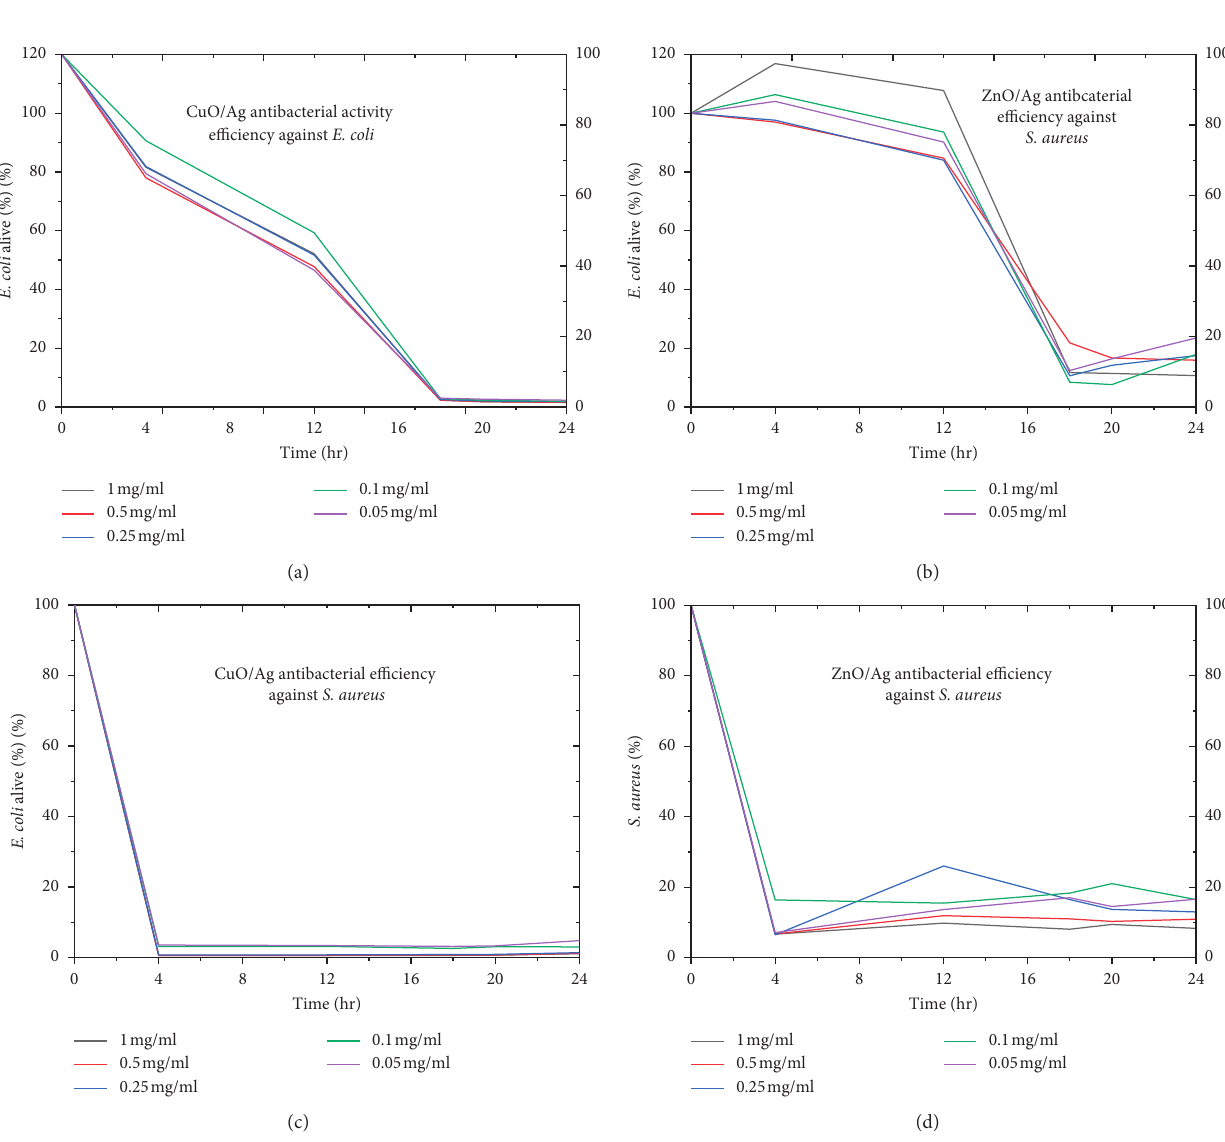
Figure 19: Kinetic growth study on E . coli and S . aureus that are alive after antibacterial activity by (a) CuO/Ag against E . coli , (b) ZnO/Ag against E . coli , (c) CuO/Ag against S . aureus , and (d) ZnO/Ag against S . aureus